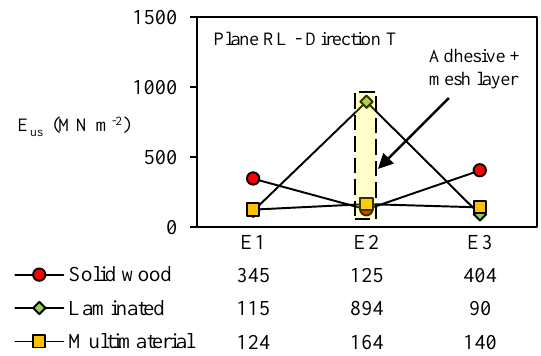
Figure 7 Dynamic Modules in Tangential